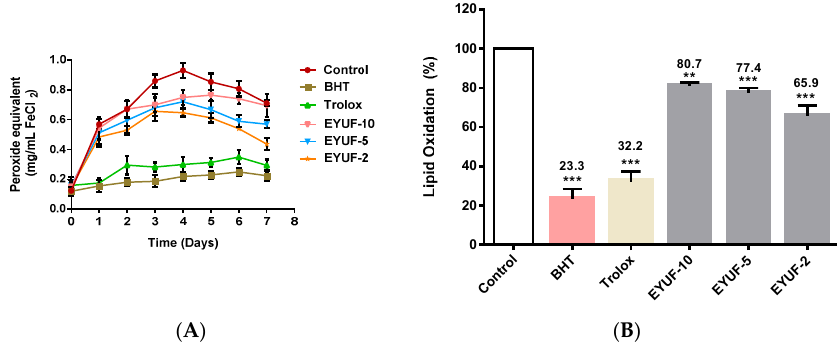
Figure 1. Effect of fractionated egg yolk protein hydrolysates on lipid oxidation by ferric thiocyanate (FTC) method. Lipid oxidation was measured in a linoleic acid model system. ( A ) Peroxide concentration was monitored every 24 h for 7 days at 500 nm; ( B ) The percentage of lipid oxidation, indicated at the top of the bar, was measured after four days incubation at 40 °C. BHT and trolox (0.2 mg/mL of each), shown in colour, were used as positive controls, while milli-Q water was used in the control instead of sample. EYUF-10, EYUF-5 and EYUF-2 fractions were collected after passing through 10, 5, and 2 kDa ultrafiltration membranes (50 mg/mL of each fraction). Data correspond to the means ± SD of three independent experiments. ANOVA was performed in Graphpad Prism version 6.0, followed by Dunnett’s multiple comparisons test. The result was considered statistically significant versus the water control ( ** = p < 0.01, *** = p < 0.001). BHT: butylated hydroxyltoluene; EYUF: Egg yolk ultrafiltered fraction.